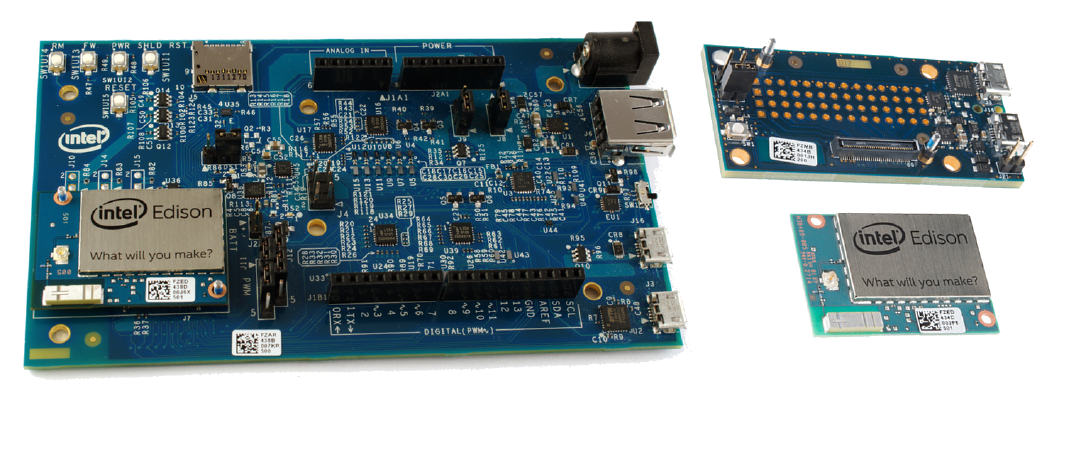
Figure 15. Intel Edison with two extension